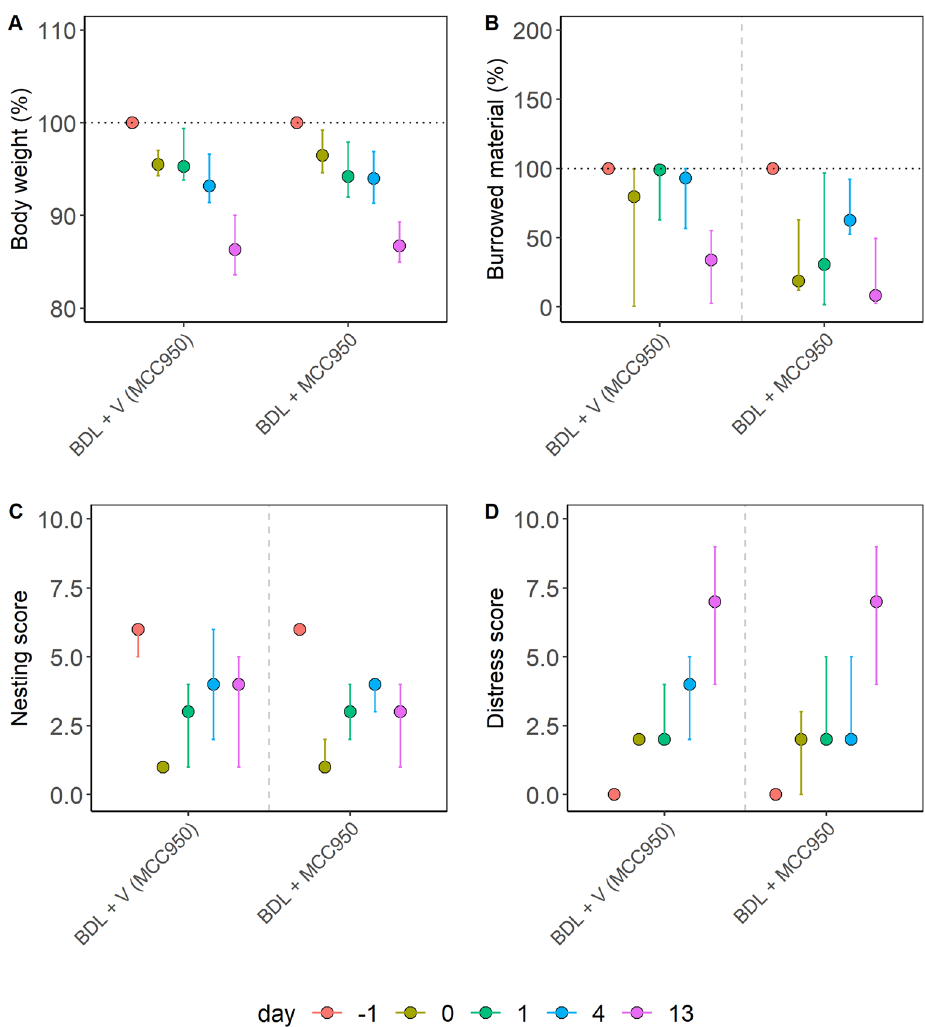
Figure 4. Distress evaluation of a cholestasis model in mice. Cholestasis was induced by bile duct ligation (BDL), and the animals were treated with an NLRP3 inflammasome inhibitor (MCC950) or the appropriate vehicle solution (V). The percentage of body weight ( A ), the percentage of burrowing activity ( B ), the nesting ( C ), and the distress score ( D ) were evaluated on the indicated days. No significant differences between the groups were determined using the Kruskal–Wallis test in ( A ) ( χ 2 = 0.16, df = 1, p = 0.69), ( B ) ( χ 2 = 2.58, df = 1, p = 0.11), ( C ) ( χ 2 = 0.05, df = 1, p = 0.82) or ( D ) ( χ 2 = 0.26, df = 1, p = 0.61). The graphs depict the bootstrapped median estimator on each experimental day and the 95% confidence intervals. ( A ) MCC950 n = 14, vehicle: n = 16; ( B ) MCC950 n = 7, vehicle n = 9; ( C ) MCC950 n = 7, vehicle n = 7; ( D ) MCC950 n = 7, vehicle n =